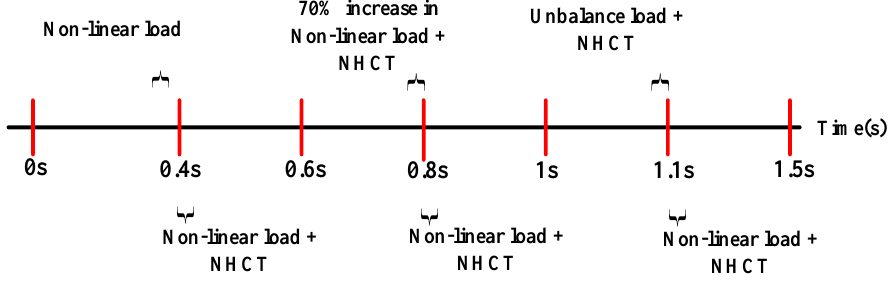
Figure 7. Working conditions selected for the proposed approach .